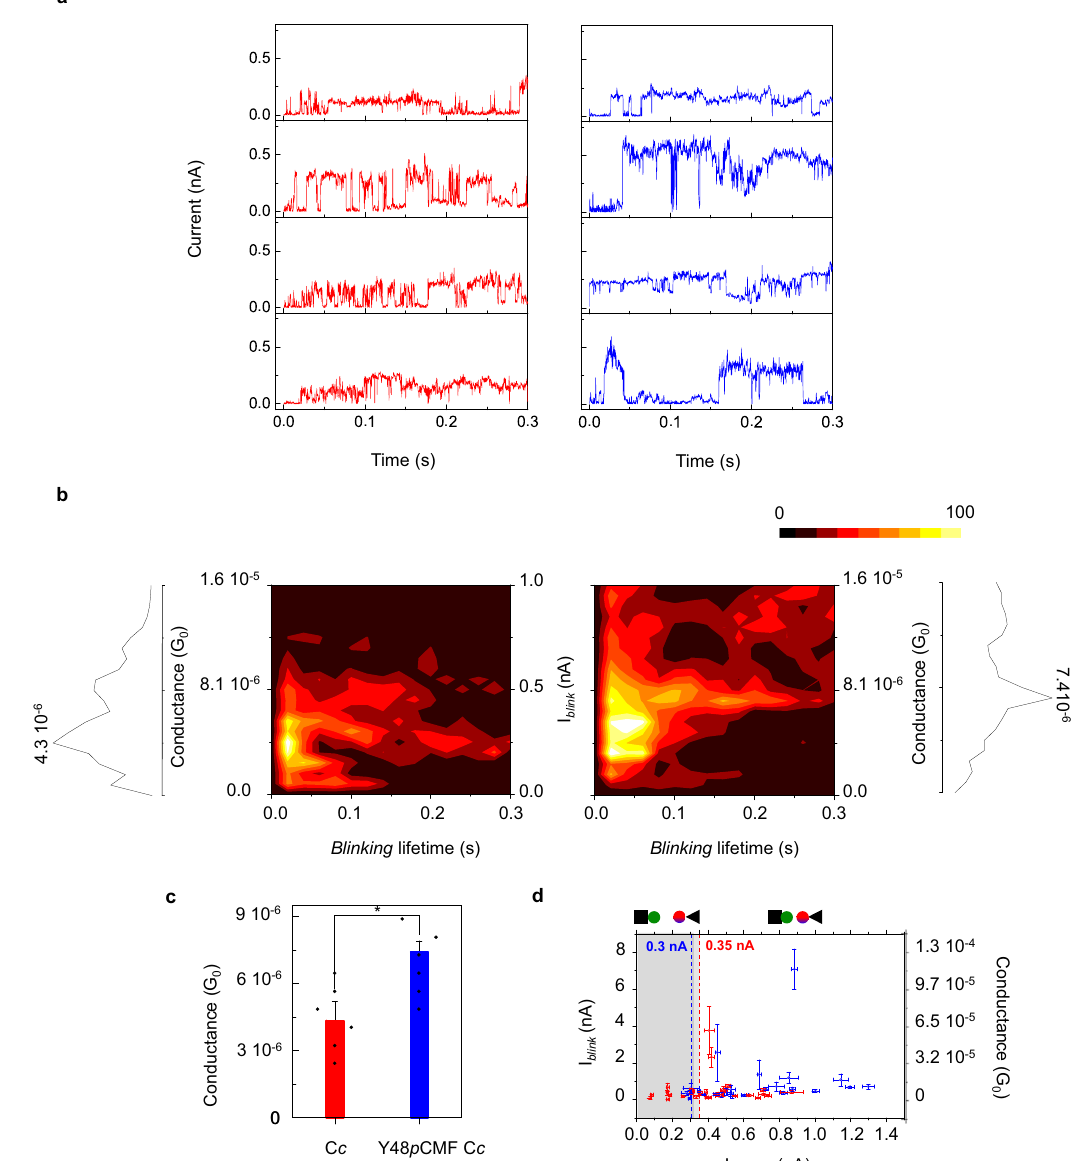
Fig. 2 | Blinking experiments. a Representative blinking recordings for C c 1 -C c (red) and C c 1 -Y48 p CMF C c (blue). Blinks are shown as transient jumps of the cur- rent fl owing between the two electrodes ata constant distance (imposed by initial current set point) and bias (800mV). b Two-dimensional histograms of blink current (I blink ) and blink lifetime for C c 1 -C c (left, n=100980 conductance values included) and for C c 1 -Y48 p CMF C c (right, n=252193 conductance values inclu- ded). Counts have been normalized to a color scale, with 100 counts representing the maximum, and 0representing the minimum.The corresponding conductance (G) pro fi les are shown. Baseline correction was applied in a and b. G=I blink /V bias is used to obtain the conductance values. G 0 =2e 2 /h=77.5 μ S, with h the Planck constant and e the elementary charge. c Plot of the averaged G values from